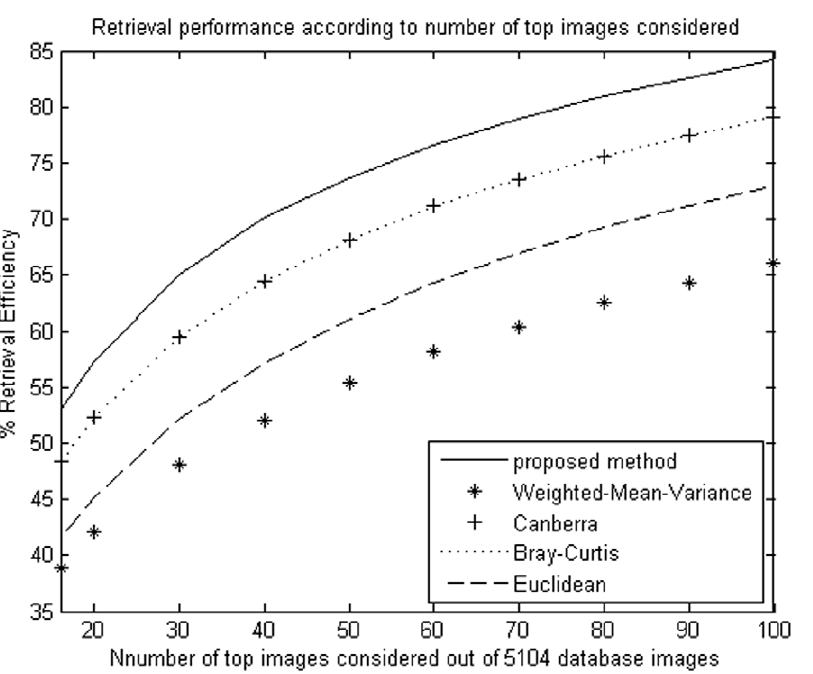
Figure 9. Average retrieval rate of database according to the number of top retrieved images using NSCT. The Outex image database (5104 images) were used.